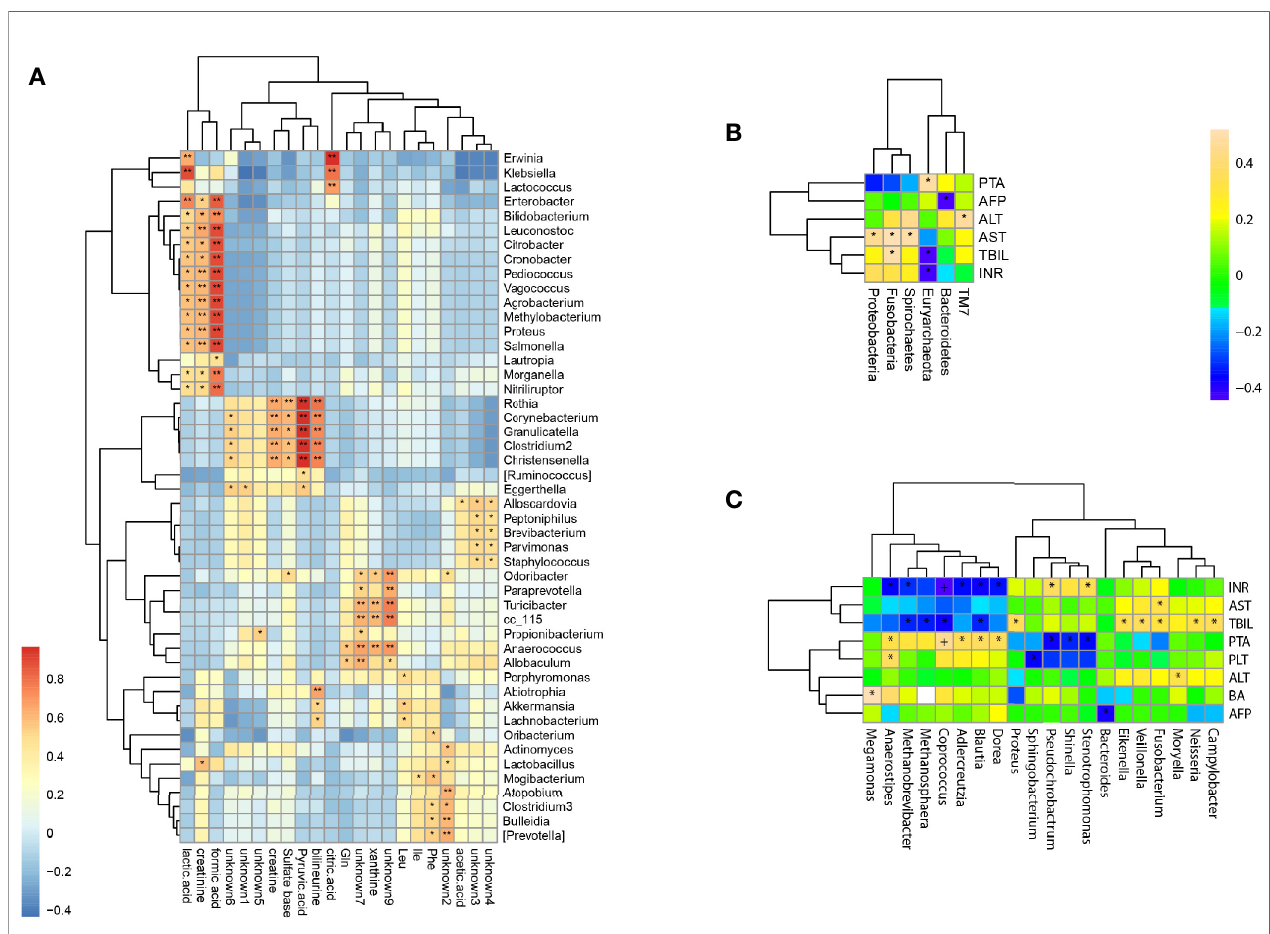
FIGURE 5 | Correlations of bacterial taxon abundance with fecal metabolites and biomedical indicators. (A) Correlations of genus abundance with fecal metabolites (asterisk means p < 0.05). (B) Correlation analysis of phylum abundance with patient ’ s serum biomedical indicators (asterisk means p < 0.05). (C) Correlation analysis of genus abundance with patient ’ s serum biomedical indicators (asterisk means p <